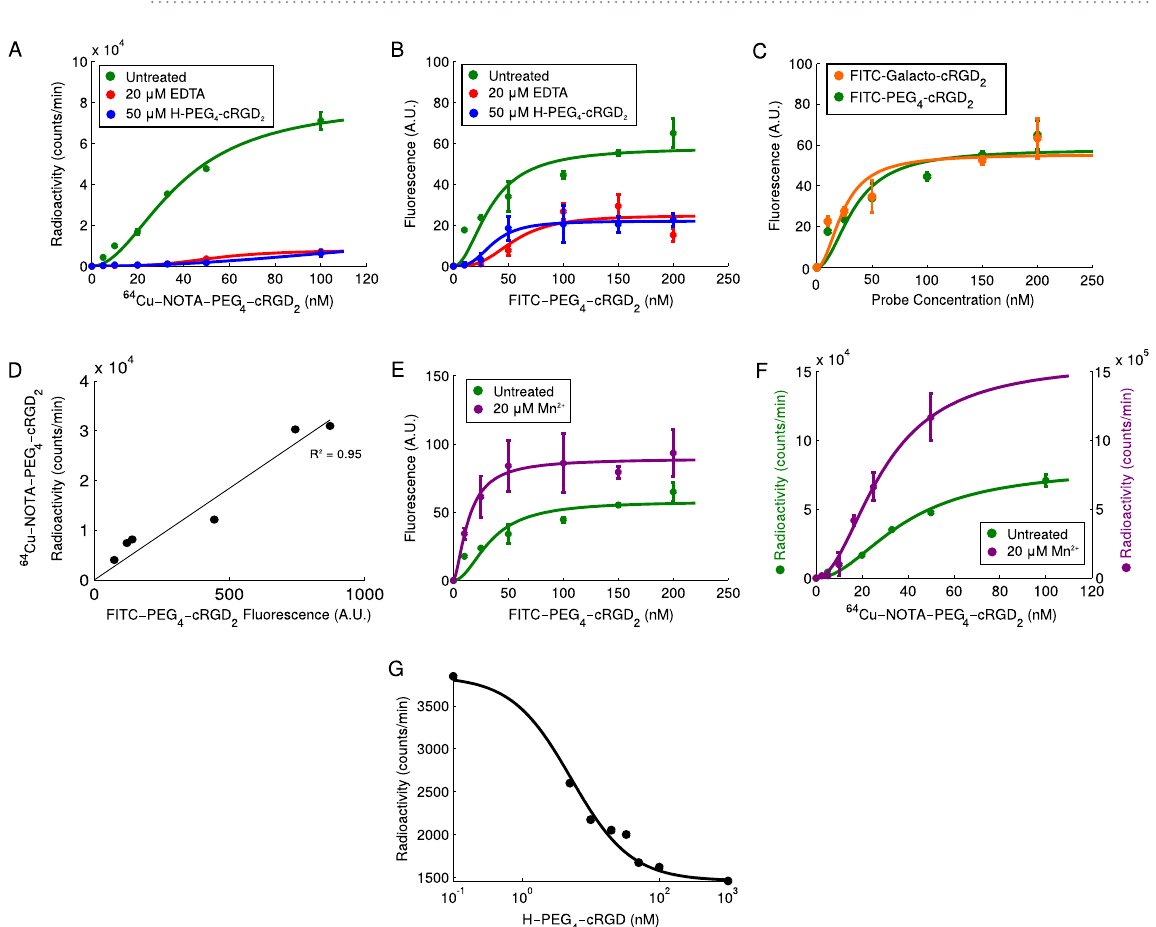
Figure 4. Binding kinetics of FITC and 64 Cu labeled cRGD 2 probes. ( A ) Radioactivity of confluent HUVEC cells incubated with varying concentrations of 64 Cu-NOTA-PEG 4 -cRGD 2 (green) and with either 20 μ M EDTA (red) or 50 μ M of H-PEG 4 -cRGD 2 (blue). ( B ) Fluorescence of the FITC-PEG 4 -cRGD 2 (green) with either 20 μ M EDTA (red) or 50 μ M of H-PEG 4 -cRGD 2 (blue). ( C ) Comparison of the fluorescence of the FITC-PEG 4 -cRGD 2 (green) with FITC-Galacto-cRGD 2 (orange). ( D ) Correlation between FITC and Cu 64 labeled cRGD 2 probes bound to HUVECs. ( E ) The fluorescence of HUVEC cells incubated with varying concentrations of FITC- PEG 4 -cRGD 2 (green) and co-incubated with 20 μ M of Mn 2 + (purple). ( F ) Radioactivity of confluent HUVEC cells incubated with varying concentrations of 64 Cu-NOTA-PEG 4 -cRGD 2 (green) and co-incubated with 20 μ M of Mn 2 + (purple). ( G ) Competition binding between 64 Cu-NOTA-PEG 4 -cRGD 2 (50 nM) and increasing concentrations of unlabeled H-PEG 4 -cRGD 2 in HUVEC